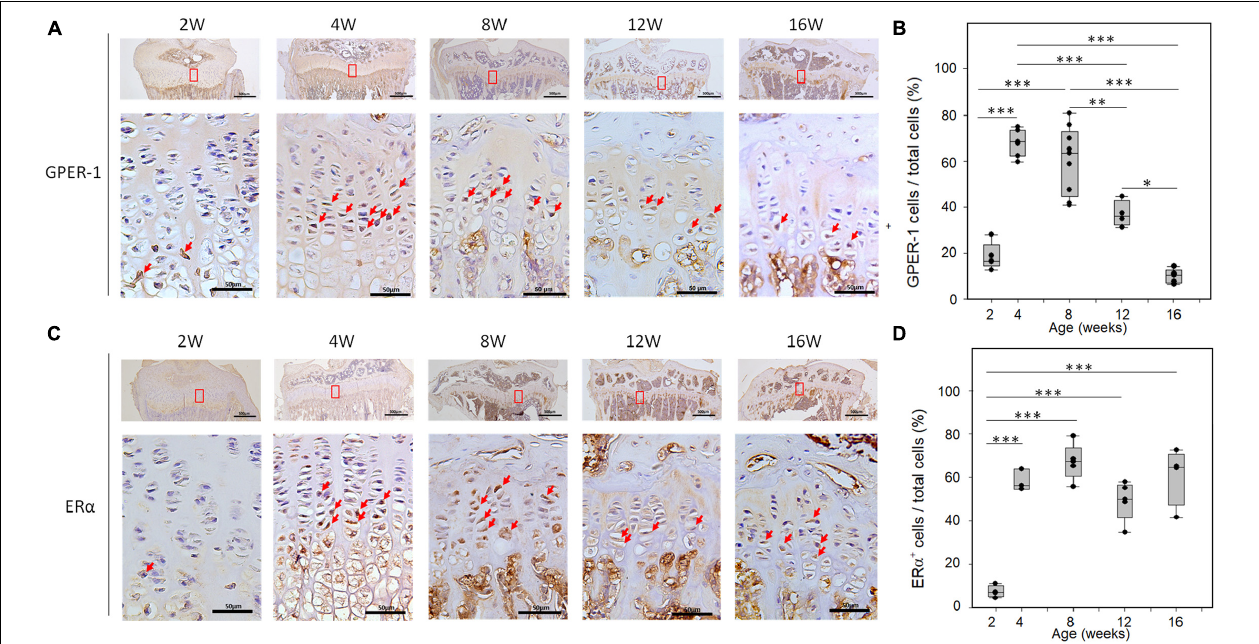
FIGURE 1 | Age-related changes of GPER-1 and ER α levels in tibia growth plates as determined via IHC staining. (A,C) Growth plate cartilage of tibias from 2-, 4-, 8-, 12-, and 16-week-old mice were stained for GPER-1 and ER α . Representative micrographs of growth plates at low (scale bars, 500 µ m) and high (scale bars, 50 µ m) magnification. (B,D) Image-J analysis of percentage of GPER-1- and Er α -positive cells from total number of hematoxylin-stained cells (total cells). Each group, N = 5. ∗ P < 0.05, ∗∗ P < 0.01, ∗∗∗ P <